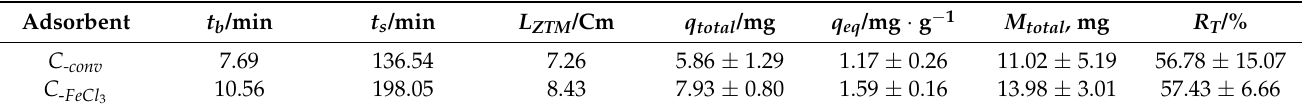
Table 1. Evaluation parameters of the fixed-bed column packed with C -conv and C - FeCl adsorption process of Bordeaux B in the influent solution.